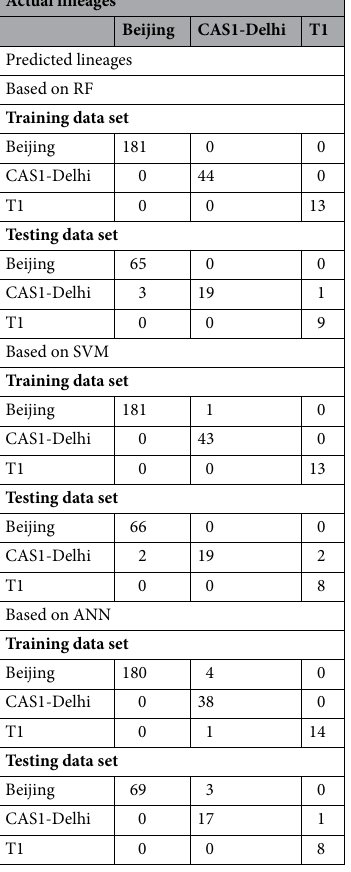
Table 6. Confusion matrix showing three major spoligotypes of MTBC from Sikkim based on actual spoligotyping conducted using reverse hybridization (row data). Predicted lineages (columns) are based on the support vector machine (SVM) and artificial neural network (ANN) analysis using 24-loci MIRU-VNTR profiles. Based on k-fold